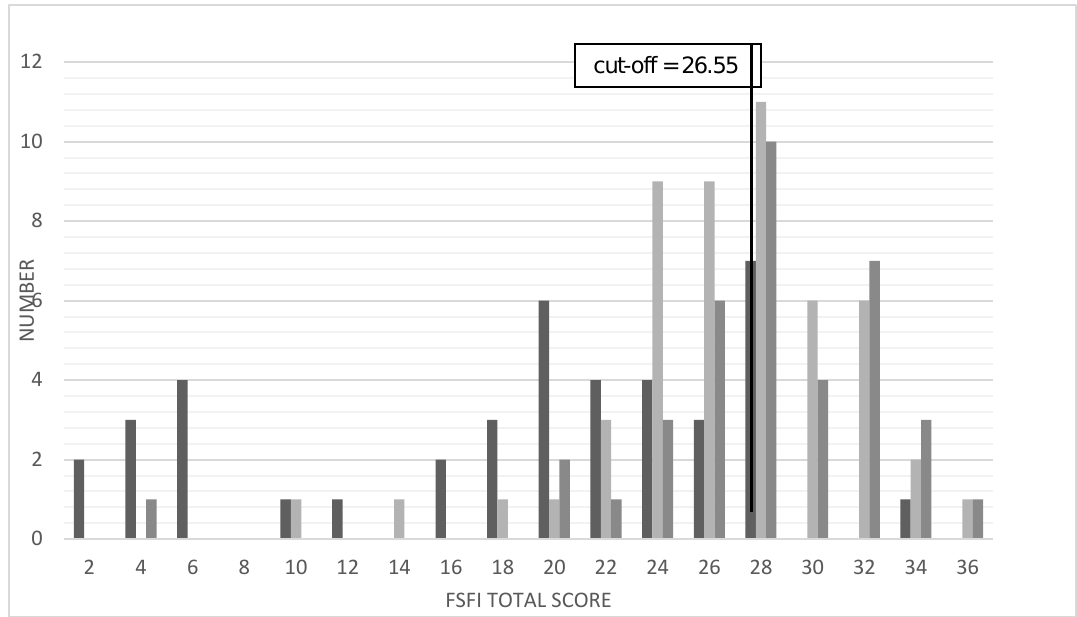
Figure 4. Distribution of the FSFI-d total scores. notes: black bars represent the FSFI-d total score at TP1 ( n = 41), the light grey bars the FSFI-d total score at TP2 ( n = 51) and the dark grey bars at TP3 ( n = 38).